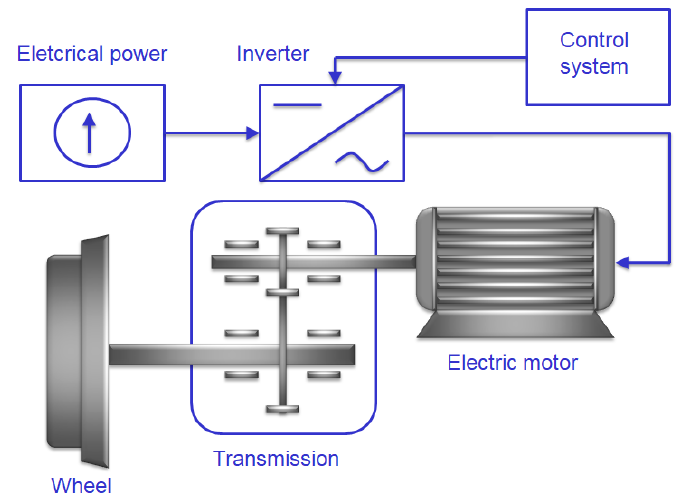
Figure 7. The structure of the drive system.